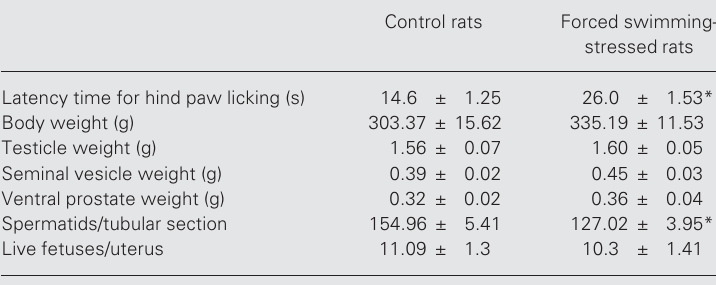
Table 1. Effect of forced swimming stress on some adult male reproductive param-